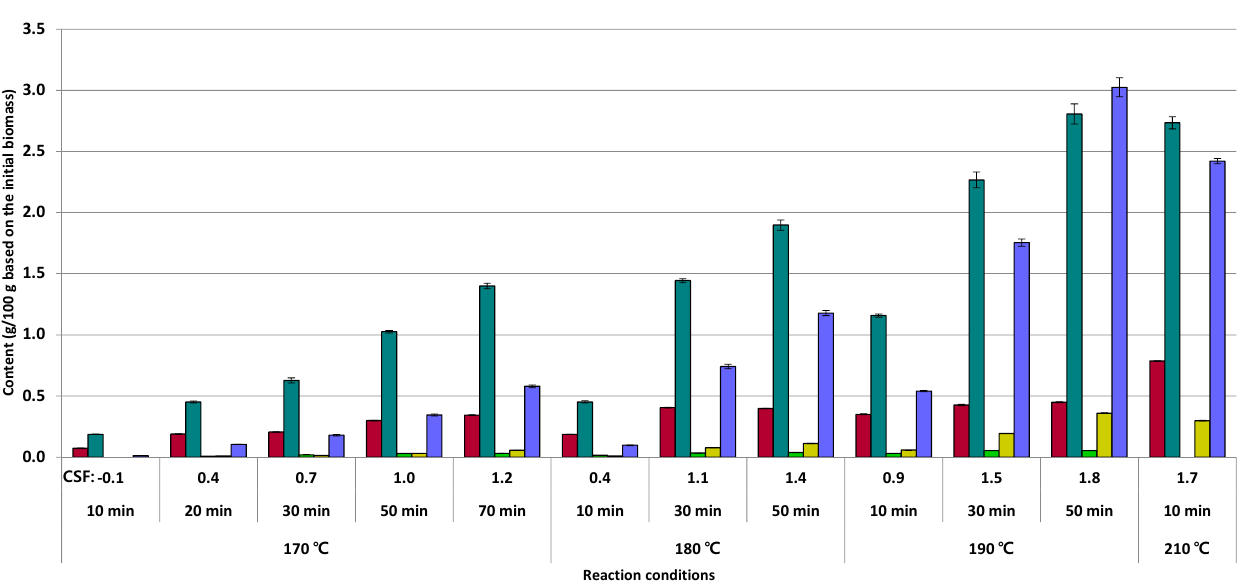
Figure 2. Sugar derivatives content (g/100 g initial biomass) of liquid hydrolysate after LHW treatment from E. pellita . The amount of furfural was less than 1% at 170 °C of reaction temperature, but it was